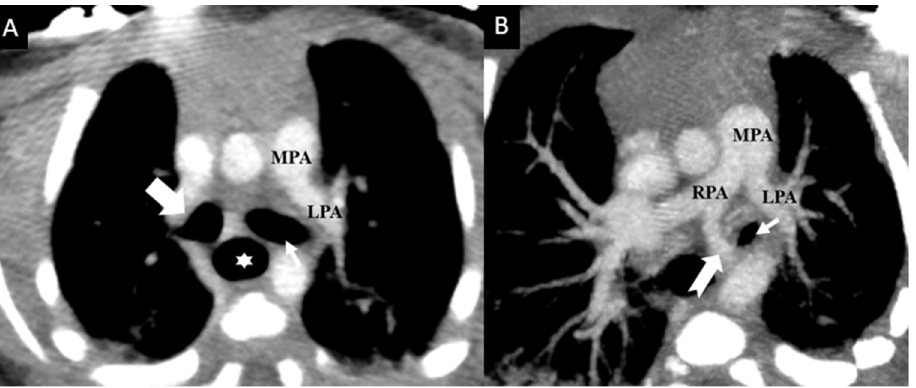
Figure 3. Newborn male with complex congenital heart disease (double outlet right ventricle, ventricular septal defect, and aortic coarctation) with PALPA. Contrast enhanced axial ( A ) and ( B ) axial oblique reconstructed Maximum Intensity Projection (MIP) images from chest CT data demonstrate a duplicated left pulmonary artery with a normally arising left upper lobe pulmonary artery (LPA) from the main pulmonary artery (MPA) coursing anterior to the left main bronchus (thin small arrow), while an anomalous left lower lobe pulmonary artery (notched arrow) coursing inferior anterior to the left main bronchus and left lateral to the esophagus (star). No anomalous vessel was seen between the trachea and the esophagus. Right main bronchus is marked with a bold white